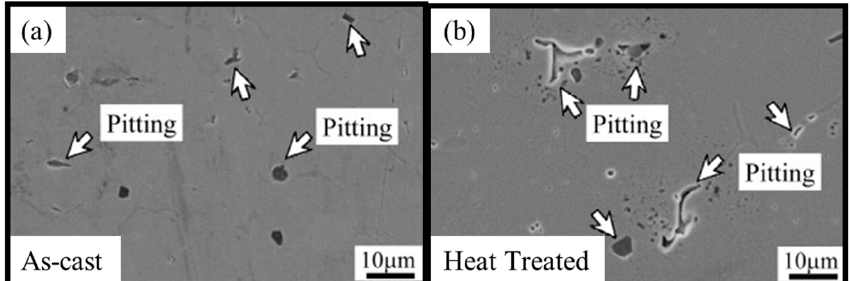
Figure 8. Pitting morphology for Al 0.5 CoCrFeNi alloy in ( a ) as-cast condition and ( b ) after heat treated at 800 °C. Heat treatment resulted in phase separation forming BCC phase. Corrosion was observed to preferentially nucleate along the interphase boundaries [35] (reprinted with permission from Elsevier).